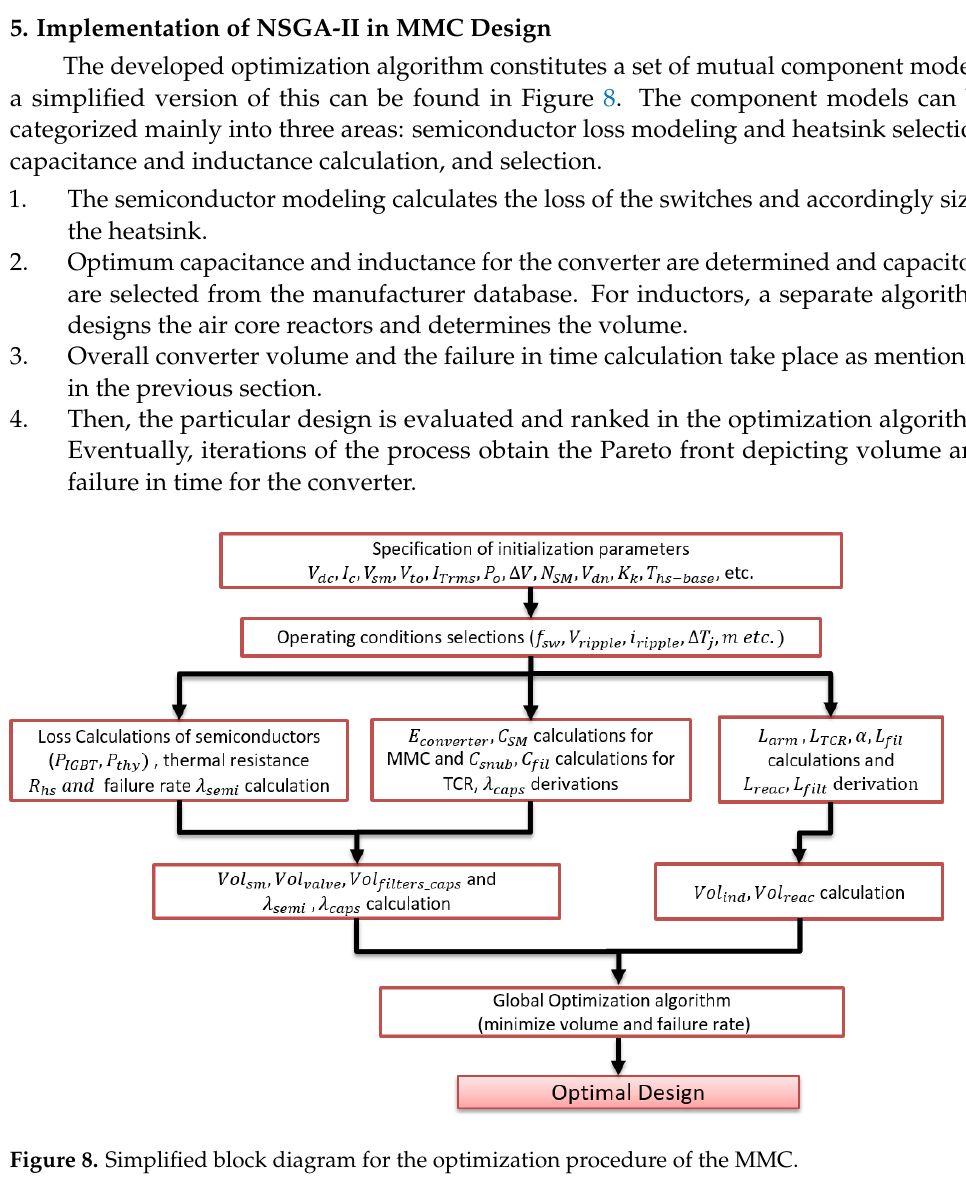
Figure 8. Simplified block diagram for the optimization procedure of the